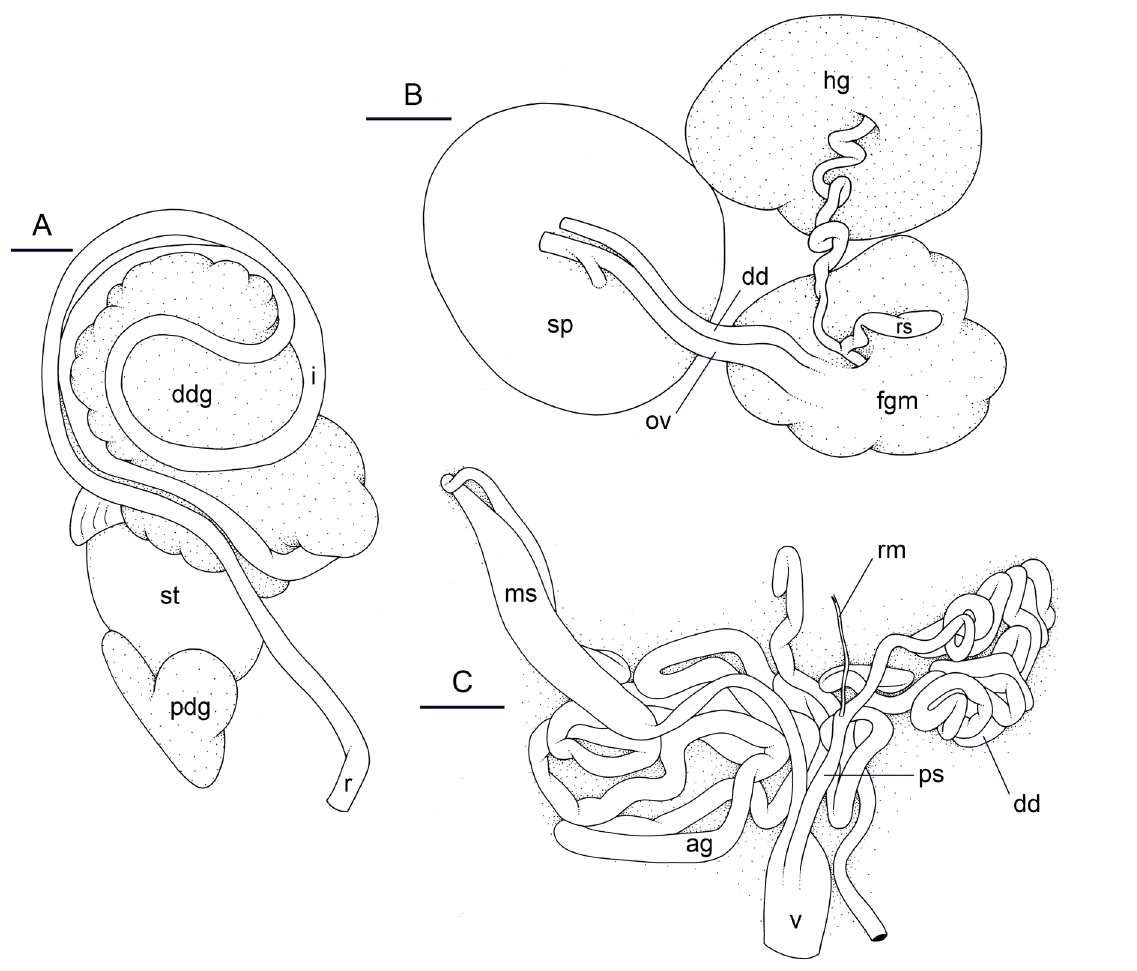
Fig. 33. Paromoionchis boholensis gen. et sp. nov., unit #1, holotype, Philippines, Bohol [3288] (PNM 041266). A . Digestive system. B . Posterior hermaphroditic (female) reproductive system. C . Male copulatory organs. Abbreviations: ag = accessory penial gland; dd = deferent duct; ddg = dorsal lobe of digestive gland; fgm = female gland mass; hd = hermaphroditic duct; hg = hermaphroditic gland; i = intestine; ms = muscular sac (of accessory penial gland); ov = oviduct; pdg = posterior lobe of digestive gland; ps = penial sheath; r = rectum; rm = retractor muscle; rs = receptaculum seminis; sp = spermatheca; st = stomach; v = vestibule. Scales = 2